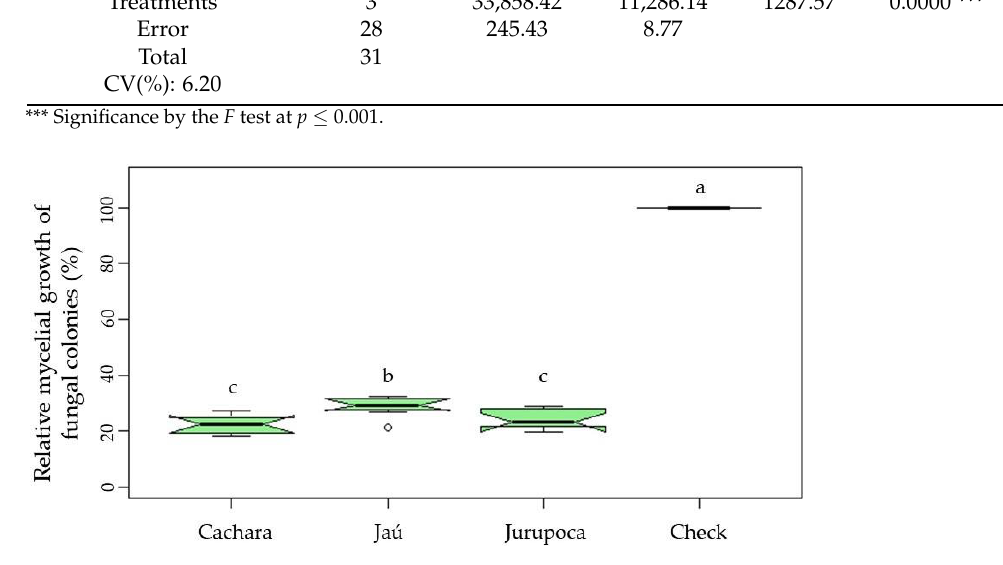
Figure 3. Boxplot distribution of relative mycelial growth of Pyricularia oryzae Triticum lineage ( PoTl ) under in vitro antagonism of three Trichoderma species. Each boxplot represents the distribution of values from three PoTl isolates (12.1.047, 12.1.146 and 12.1.207). Means followed by the same letters (a – c) are not significantly different using the Tukey test at p ≤ 0.05.